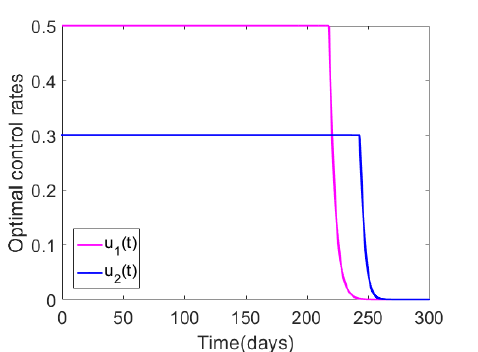
Figure 3. Numerical results illustrating the impact of the bounds for the control rates, with the initial guess for the controls set to u 1 = 0.45 and u 2 = 0.3, and the bounds for these controls fixed to q 1 = 0.5 and q 2 = 0.3. The remainder of the model parameter values are as in Table